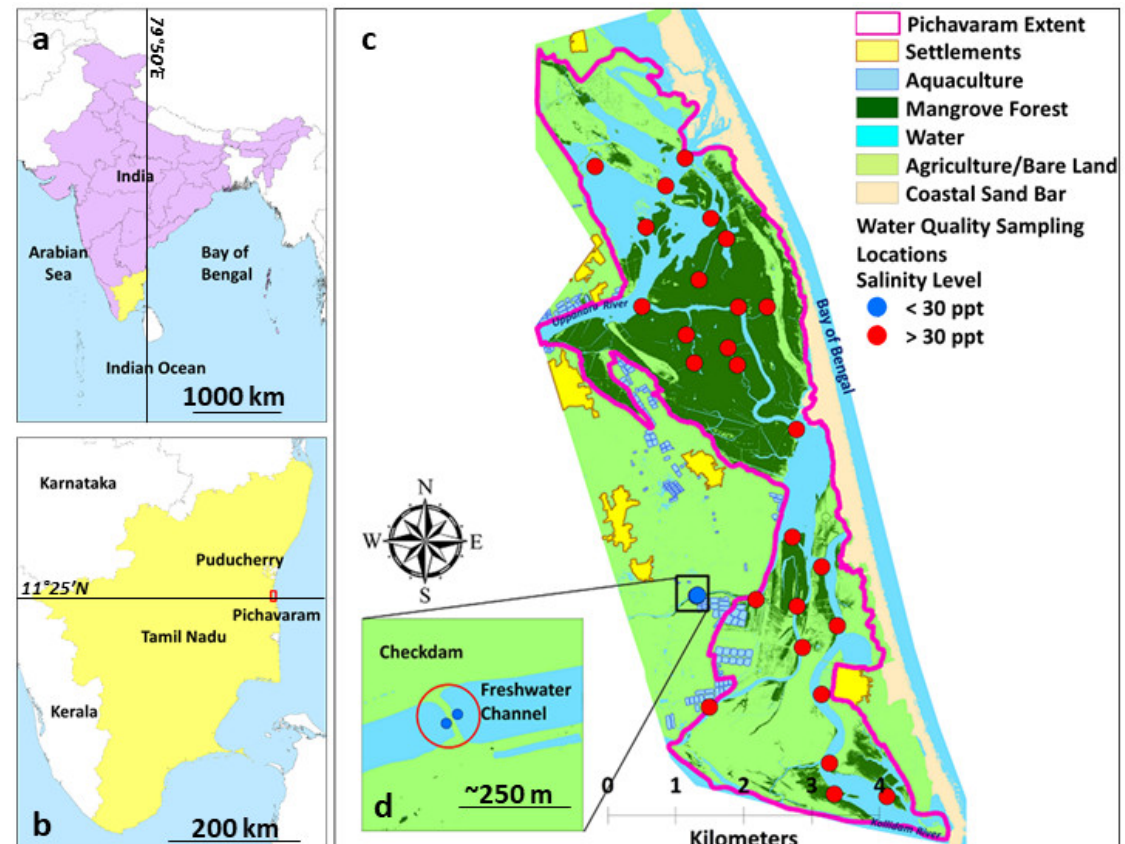
Figure 2. Location of the Pichavaram mangroves in Tamil Nadu, Southeast India ( a , b ). The mangrove area, along with the adjacent land-use and land-cover such as agriculture, aquaculture, check-dams on freshwater streams, and settlements, is illustrated ( c ). Locations of water quality samples are also shown along with the observed salinity levels ( d ).